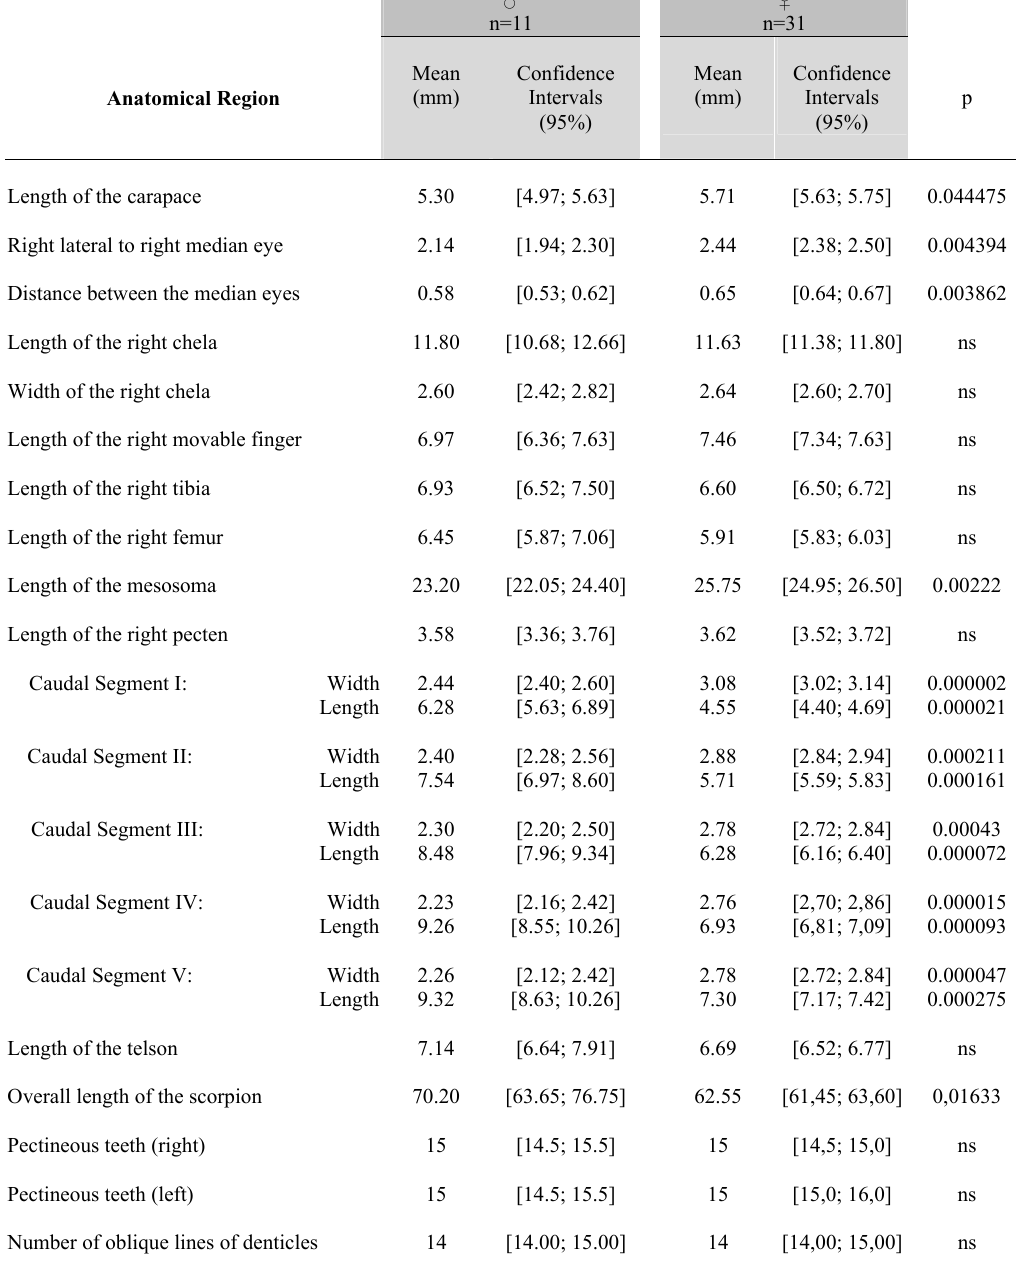
Table 3 . Morphometric data: medians and 95% confidence intervals of male and female specimens of Tityus gonzalespongai n . sp